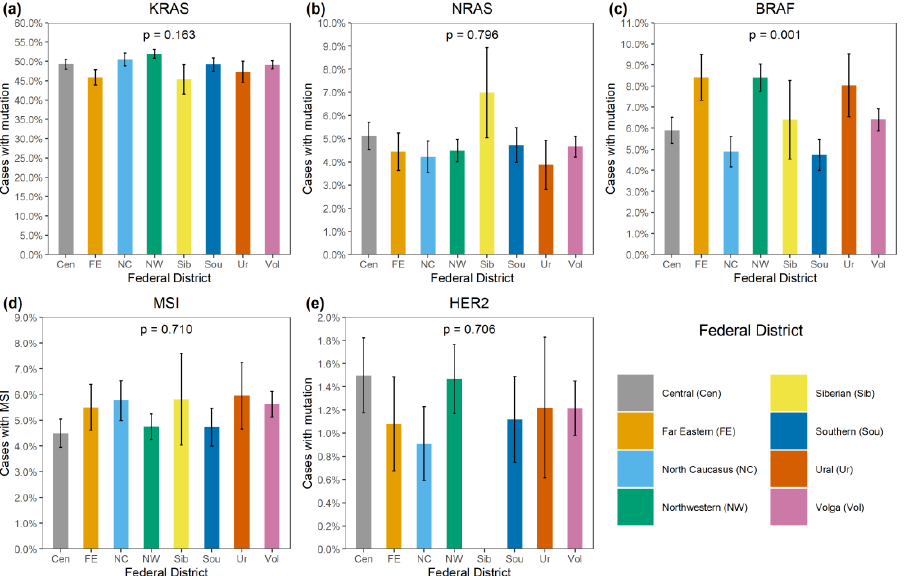
Figure 3. Distribution of genetic alterations in patients from various regions of Russia. ( a ) KRAS mutation, ( b ) NRAS mutation, ( c ) BRAF mutation, ( d ) MSI, ( e ) HER2 amplification.